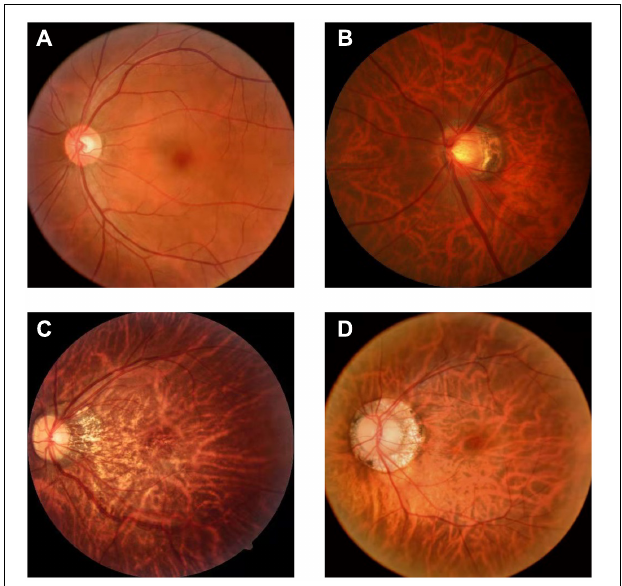
FIGURE 1 | Color photo of fundus: (A) fundus of normal eye: It has clear boundary and clear blood vessels, and the overall color is rosy; (B) fundus of high myopia: It has blurred boundary, parapapillary atrophy and leopard eye fundus; (C) progressive parapapillary atrophy: It has blurred boundary; (D) unprogressive parapapillary atrophy: It has clear borders.